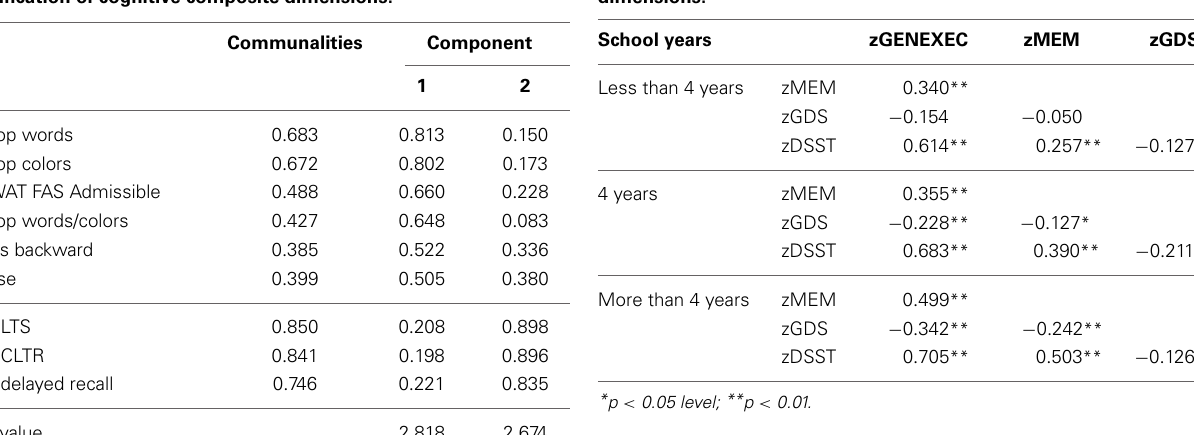
Table 2 | Principal component analysis with Varimax rotation: identification of cognitive composite dimensions.